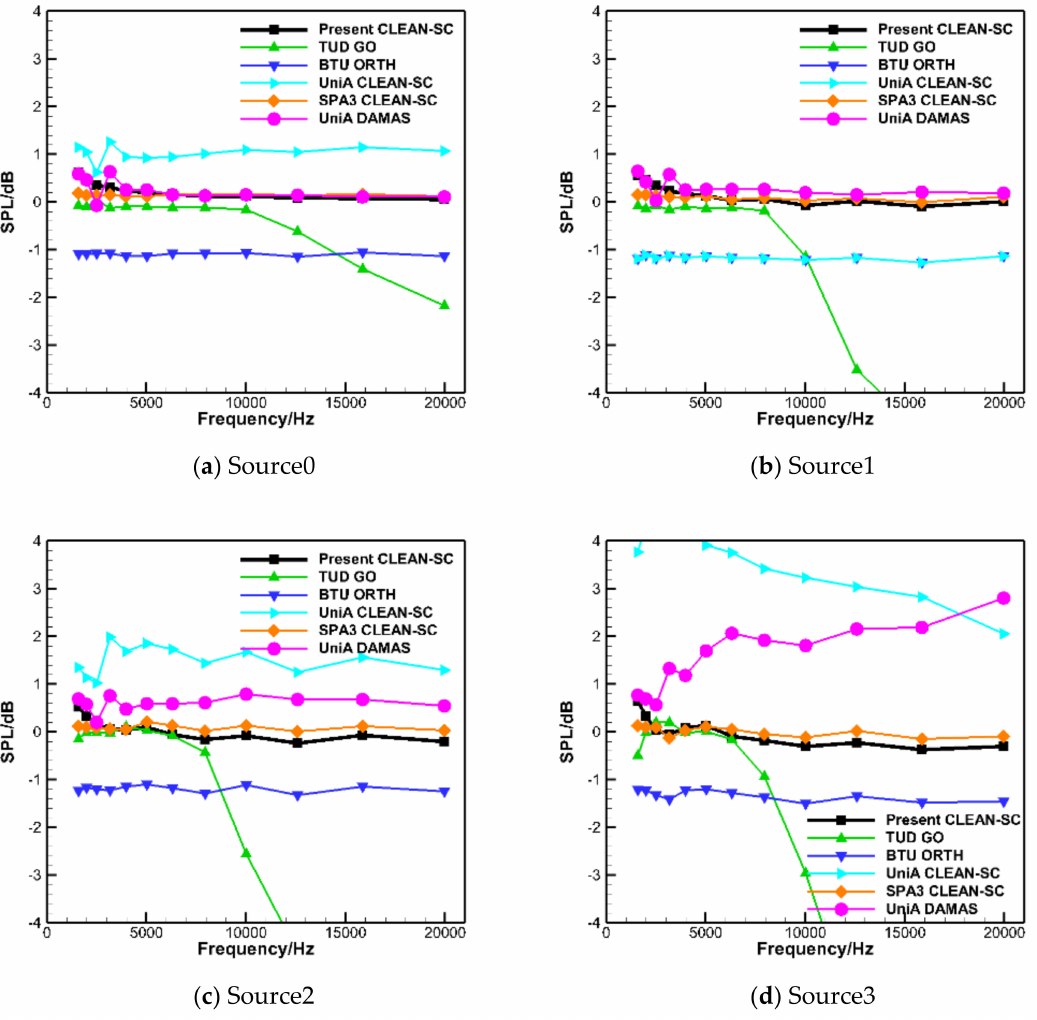
Figure 7. Comparison of the present results with other studies for subcase